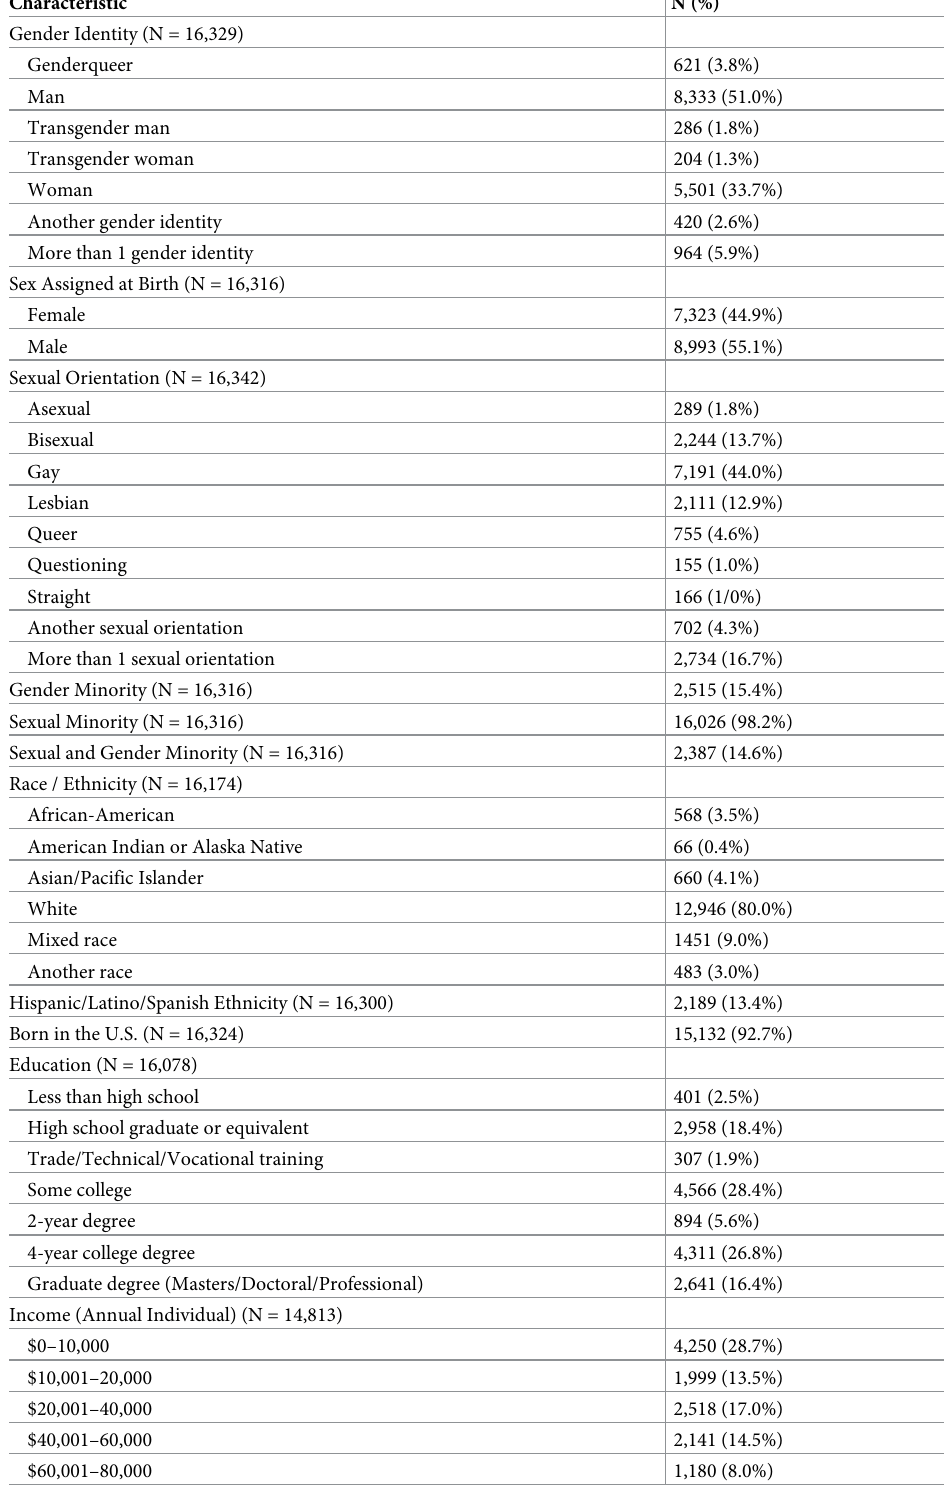
Table 1. Participant